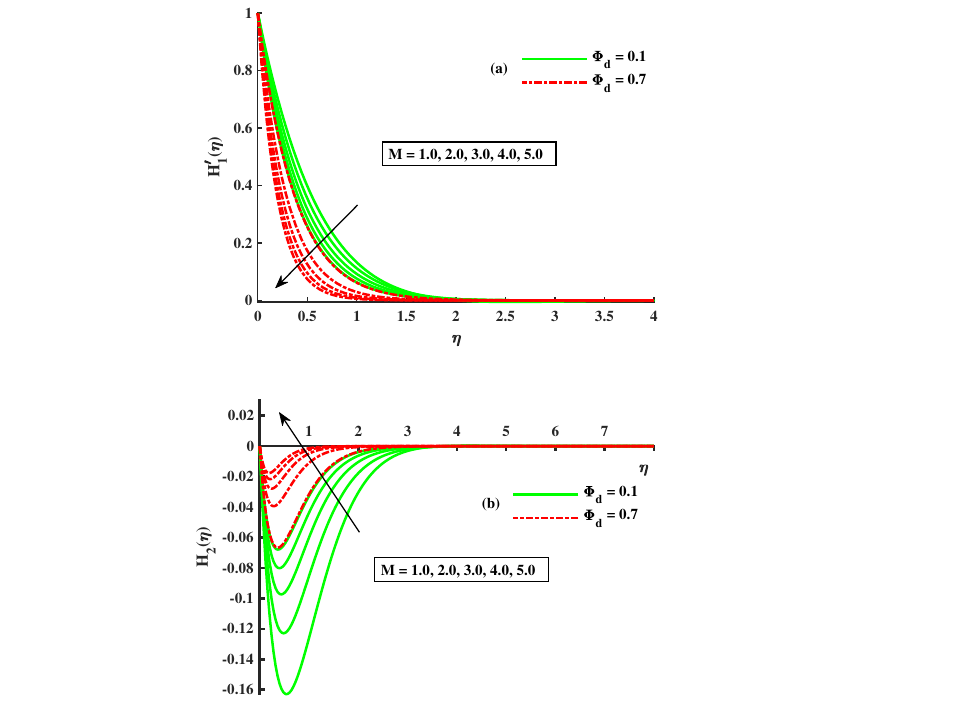
Figure 2. Influence of M and φ d on ( a ) H (cid:48)